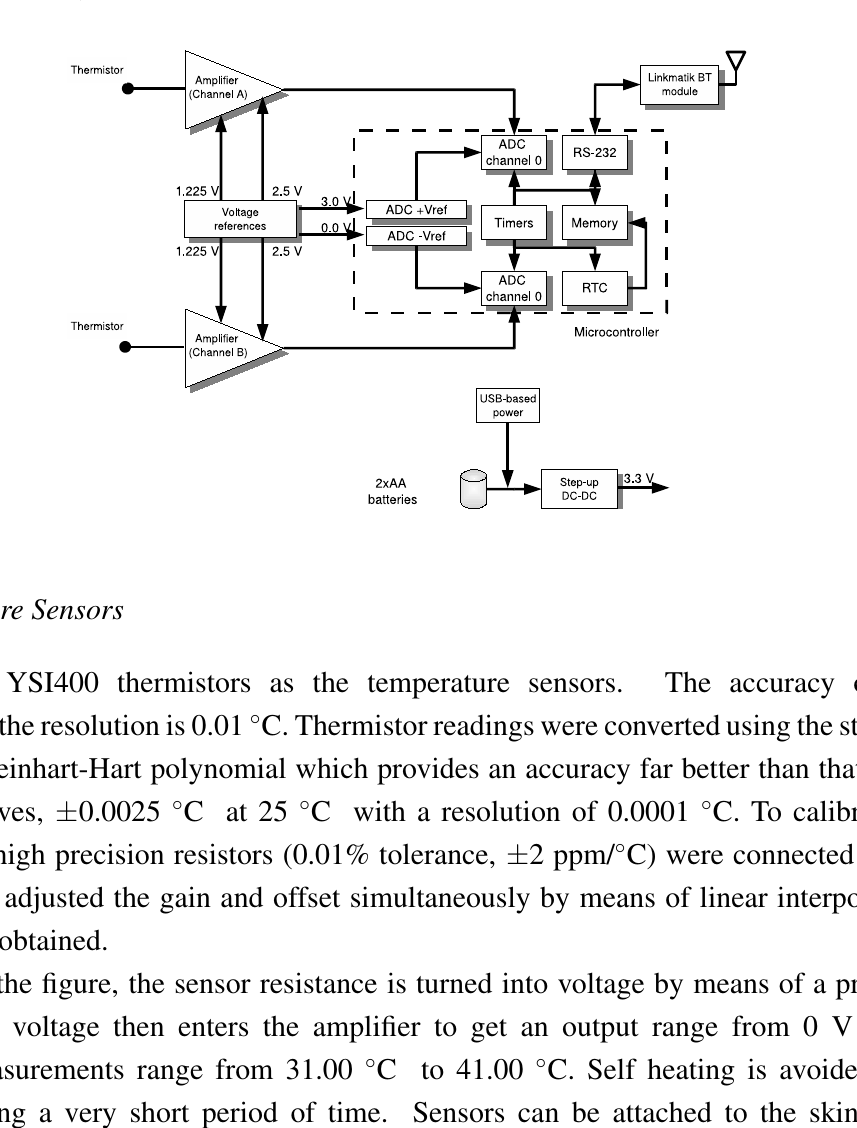
Figure 1. Block diagram of the high-accuracy/high-frequency temperature monitoring device